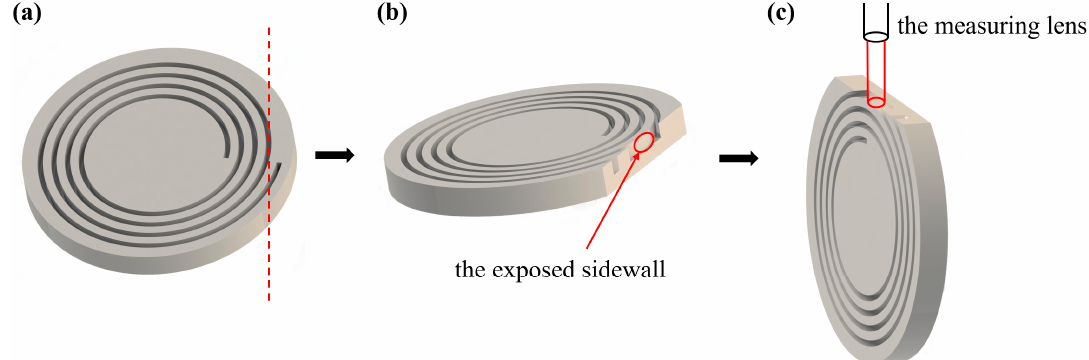
Figure 3. Measurement illustration of sidewall roughness: ( a ) cutting the sample, ( b ) the sidewalls of marked area were completely exposed, allowing roughness characterization by white light interferometer, and ( c ) the sample was placed vertically under the measuring lens of the white light interferometer, which was then adjusted to focus on the exposed sidewall area for roughness measurement.